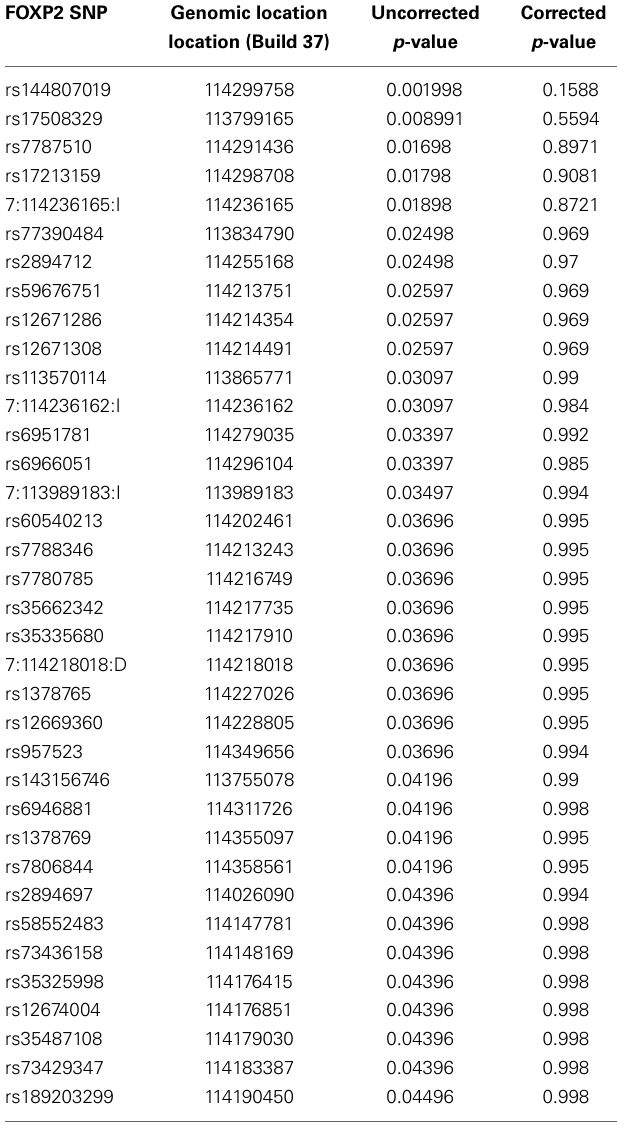
Table 3 | Suggestive FOXP2 SNPs for the association with caudate nucleus